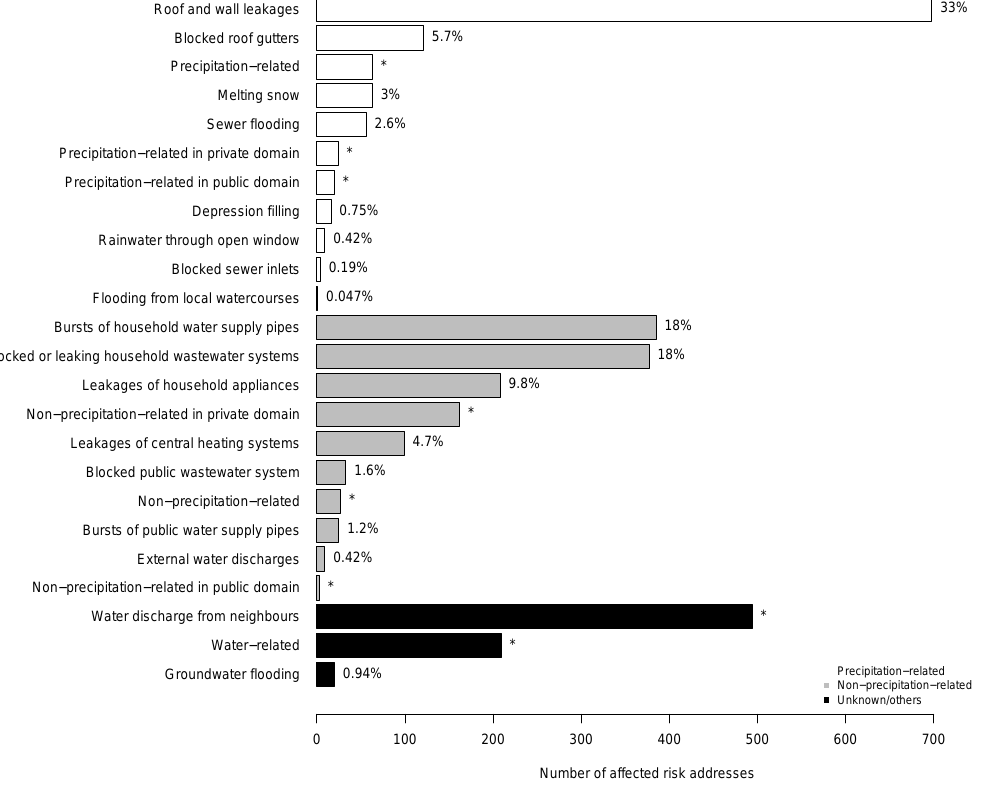
Figure 2. Occurrence rates and relative occurrence frequencies of failure mechanisms causing water-related claims ( n = 3126). An asterisk next to a bar indicates a residual group: a group of claims for which exact failure mechanisms could not be derived from communication transcripts. Percentages are based on the number of claims in the non-residual